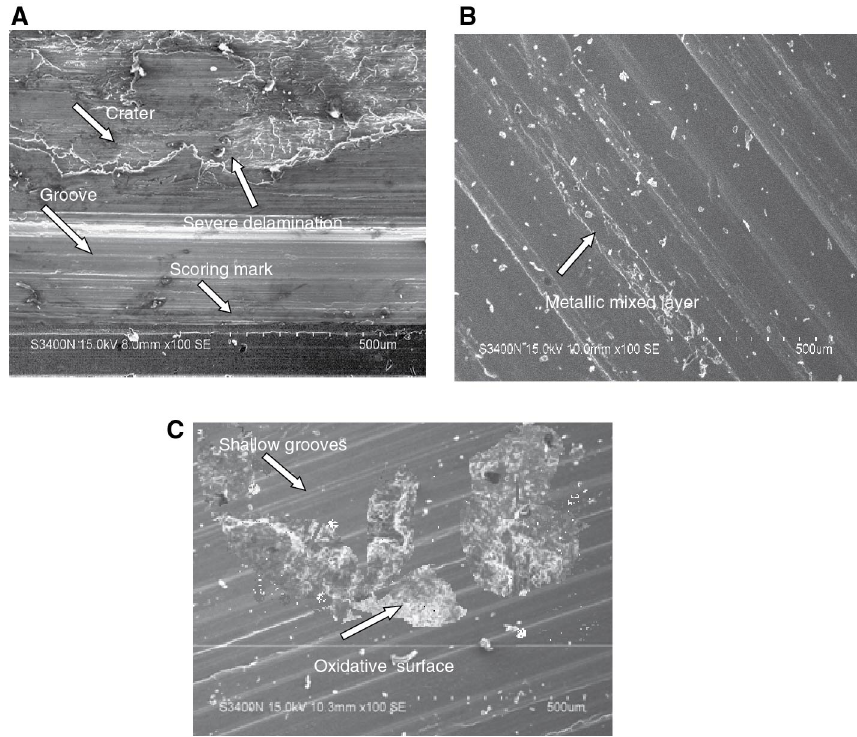
Figure 9: SEM images of worn surfaces of (A) as-cast alloy, (B) SD alloy and (C) SD+HC alloy at load of 50 N and sliding velocity of 1.5